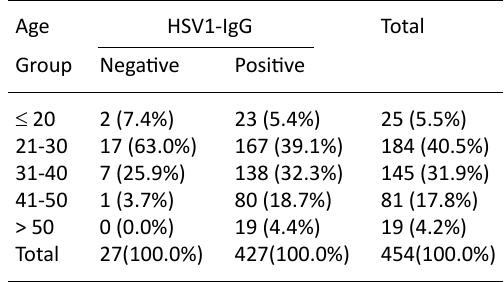
Table 1. HSV-1 Seroprevalences in Iraqi healthy blood donors, grouped according to age.